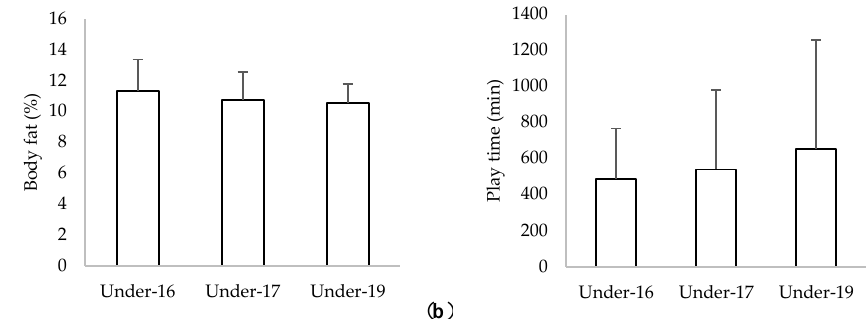
Figure 1. Descriptive statistics (mean and standard-deviation) of ( a ) body fat and ( b ) time of play. Descriptive statistics of triple hop and countermovement jump for each age group can be observed in Figure 2. The under-19 group presented the highest averages in triple hop bilateral (7.4 m), in triple hop left and right legs (6.7 m), and in CMJ (40 cm). Signifi- cant differences between age groups were found in triple hop right leg ( p < 0.001; 𝜂 2 = 0.373) and left leg ( p < 0.001; 𝜂 2 = 0.245); triple hop bilateral ( p < 0.001; 𝜂 2 = 0.523); and countermovement jump ( p < 0.001; 𝜂 2 = 0.487).